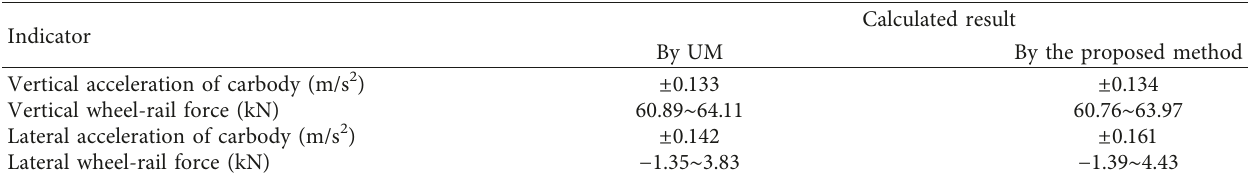
Figure 4: Dynamic responses of the train-track system subject to impact loads: (a) wheel-rail force and (b) rail displacement at the impact location. Table 3: Calculated responses of CRH3 by UM and the proposed method.